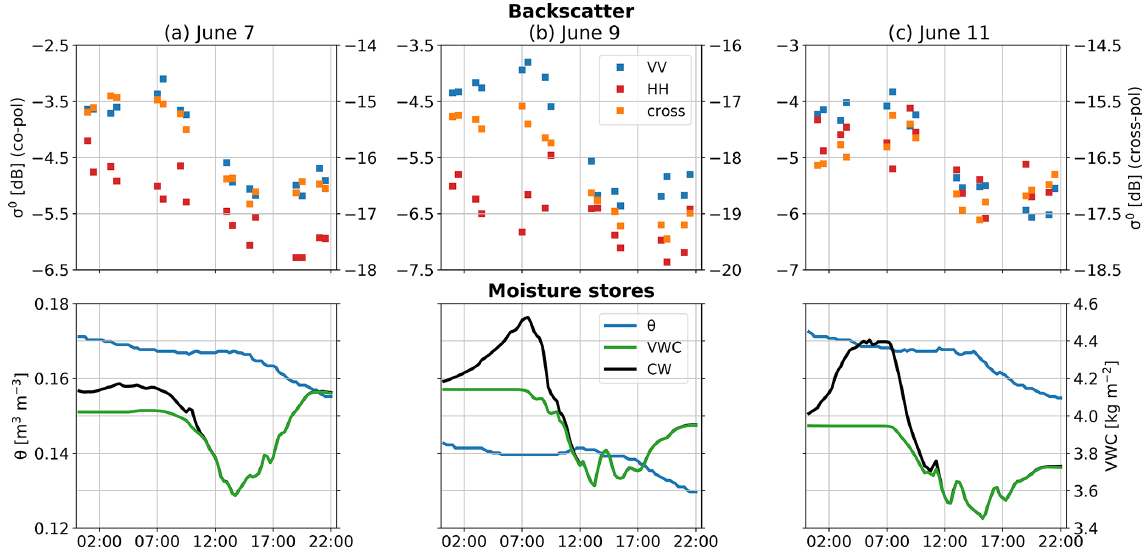
Figure 10. Diurnal behaviour of backscatter (VV-, HH-, and cross-pol) and moisture (soil moisture, VWC, and SCW) for 3 individual days without rainfall. These days were selected from the period presented in Fig. 9.